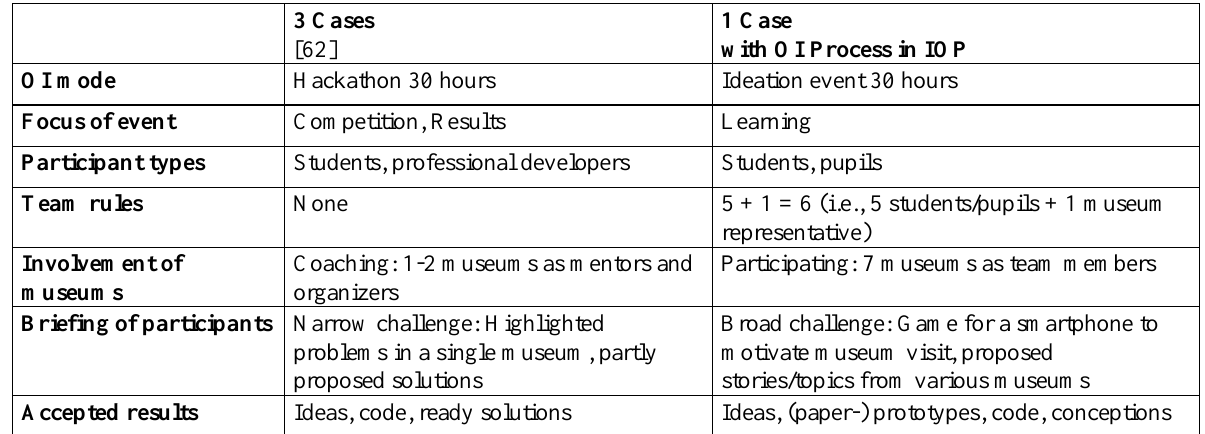
Table 2. Characteristics of OI in the case IOP (extended from